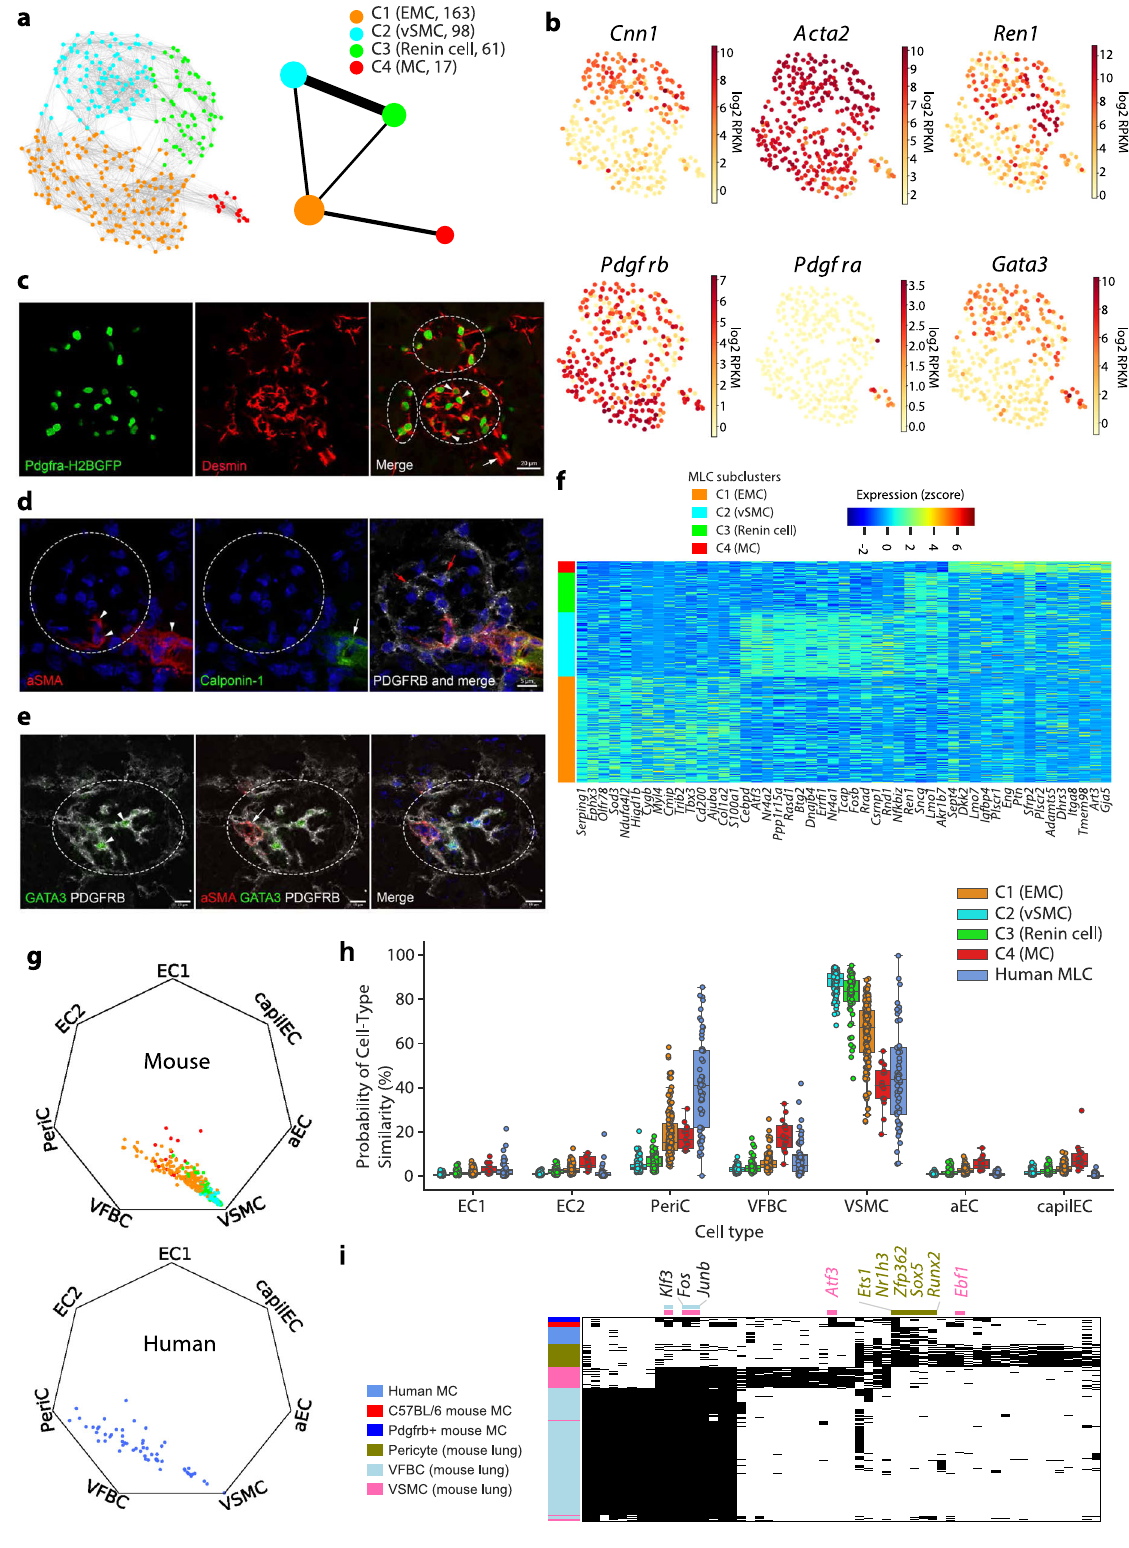
summarized data in Fig. 3d). EGFP + glomerular cells demon- strated a robust activation of phagocytosis at 37 °C as 63.7% of cells (1508/2368, n = 3) showed positive signal (Fig. 3c, d). Uptake of beads by mouse glomerular EGFP + cells was further visualized by a confocal microscopy analysis, which showed co- localization of fl uorescent beads with EGFP + glomerulus-